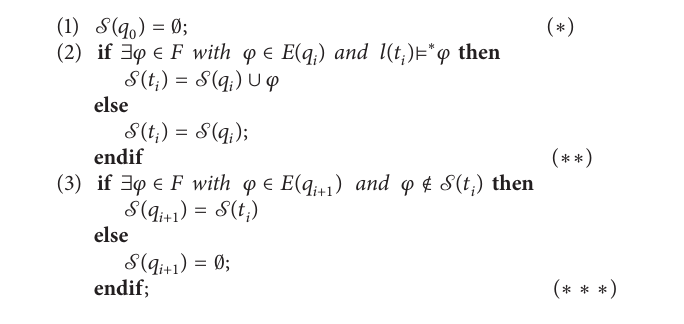
attached to the states and transitions. 𝐹 = {𝛼 U 𝛽, (𝛼 U 𝛽) U 𝛾} and S (𝑞 0 ) = 0 . S of the transition 𝑡 0 = (𝑞 0 , 𝛼, 𝑞 1 ) is 0 , because ) = 0 , because ∄𝜑 ∈ 𝐹 ∩ 𝛼 cannot satisfy (𝛼 U 𝛽) U 𝛾 . S (𝑞 1 ) s . t . 𝜑 ∈ S (𝑡 ) . The formula is expanded recursively 𝐸(𝑞 1 0 until S (𝑞 3 ) = 0 ; that is, the final state is